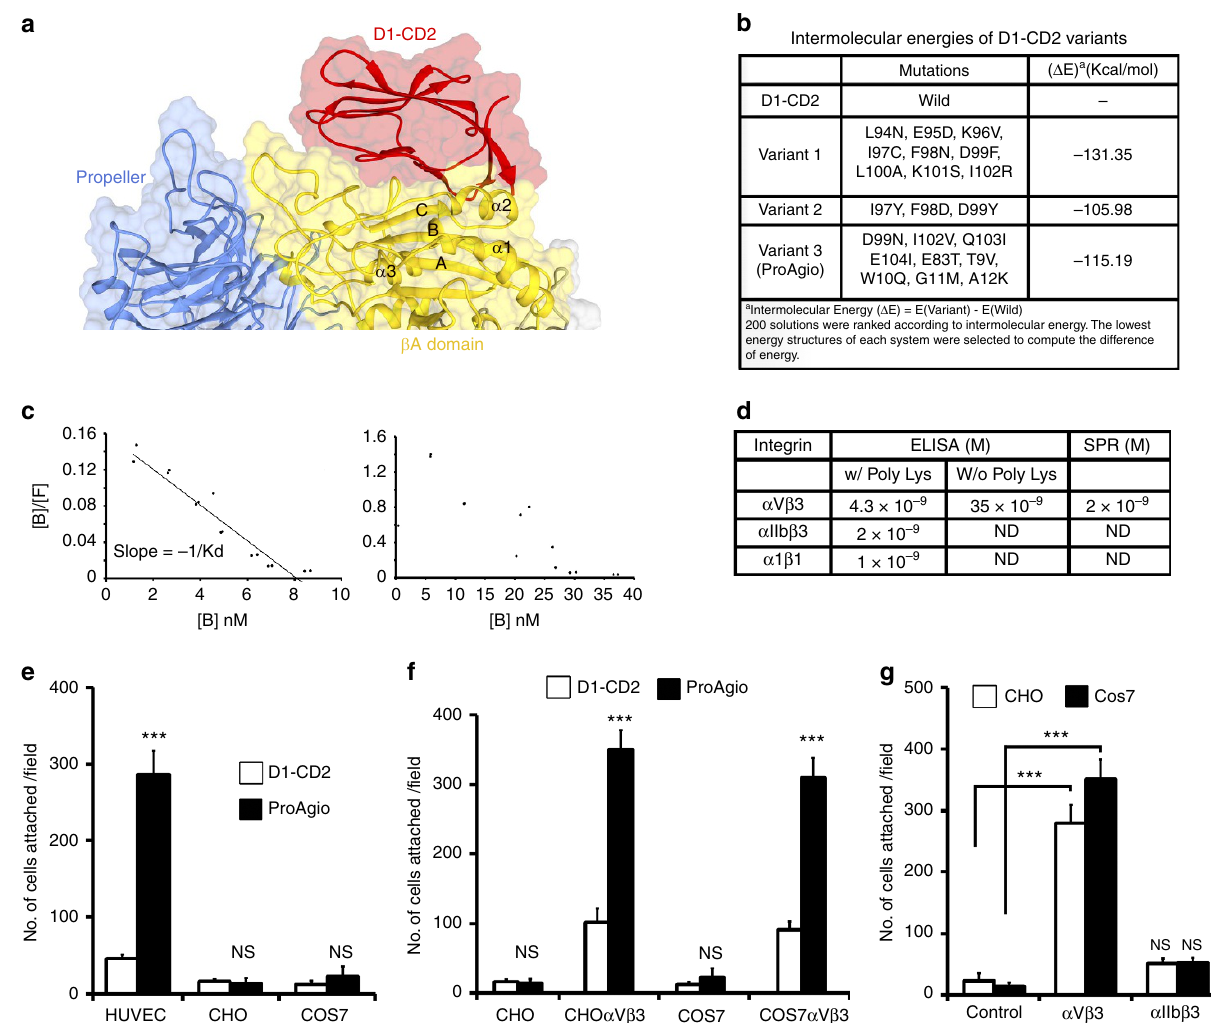
Figure 1 | Design of protein agent ProAgio binds to integrin a v b 3 at a novel site ( a ) Docking of D1-CD2 to b A domain of integrin b 3 using software Haddock 2.1. The regions form the D1-CD2 docking site are highlighted. ( b ) Docking of D1-CD2 and three variants (mutations indicated) to b A domain of integrin b 3 as in a . The ( D E) is the difference of docking energy between D1-CD2 and a variant calculated by the docking programme. ( c ) The representative Scatchard plots of binding data of binding of ProAgio to integrins a v b 3 in the presence of 3mM polyLys (Left) and absence of polyLys (Right). The dots are binding data. Solid line in left is fitting line. The fitting line clearly indicates n ¼ 1 for one-to-one binding. ( d ) The deduced dissociation (Kd) constants of ProAgio to integrins a v b 3 , a IIb b 3 , and a 1 b 1 from the ELISA and SPR binding analyses. The n.d means the Kd could not be or were not determined. ( e , f ) Attachment of indicated cells to culture plate on which ProAgio (filled bars) or D1-CD2 (open bars) was coated was measured by counting the cells that attached to the plate after washing. ( g ) Attachment of CHO (open bars) or COS-7 (filled bars) cells with/without (control) expression of a v b 3 or a IIb b 3 to culture plate on which ProAgio was coated was measured by the same cell counting as in ( e ) and ( f ). The control is CHO cells without integrin expression. The error bars in e , f and g are s.d. from measurement of five independent experiments. NS P 4 0.05, *** P o 0.001 calculated by unpaired two-tailed Student’s t -test. ND, not determined; NS, not significant.